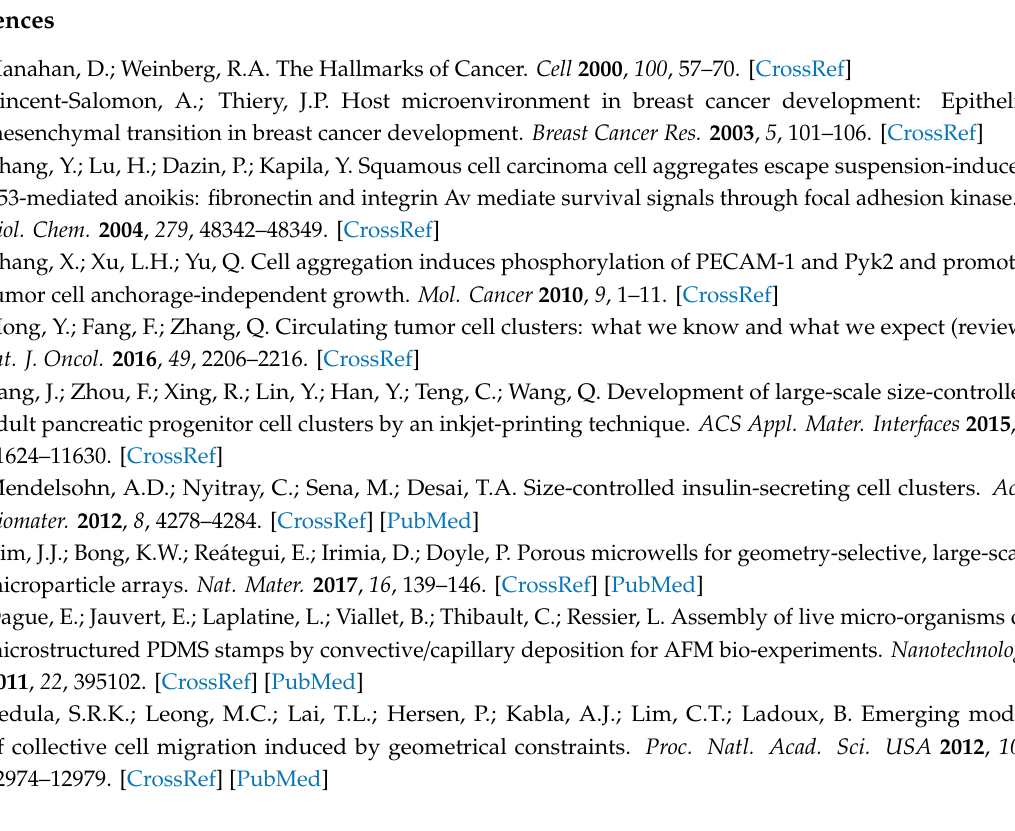
Figure S1: Surface plot (top view) showing the electric field strength in the (a) absence and (b) presence of pillars (filled white circles) in a plane 9.0 µ m above the BPE array under a potential bias leading to a spatially averaged electric field of 4546 V / m. Line plot taken along the midline of the third row of BPEs in the (c) absence and (d) presence of pillars. Figure S2: The data of Figure 2 (main text) plotted with error bars that indicate the standard deviation in the number of cells captured. Plot of the average number of cells captured at each BPE length at ∆ U = 20, 23, and 26 V / min. Data obtained at t = 5 min after initiation of driving tot pp (70 kHz). Flow rate, 200 nL voltage. Figure S3: The data of Figure 4 (main text) plotted with error bars that indicate the standard deviation in the number of cells captured. Plot of the average number of cells captured at each BPE length at ∆ U tot = 26 V pp (70 kHz). Flow rate, 200 nL / min. Data obtained at t = 1 and 5 min after initiation of driving voltage. Figure S4: The data of Figure 5 (main text) plotted with error bars that indicate the standard deviation in the number of cells captured. Plot of the average number of cells captured at each BPE length at ∆ U tot = 50, 60, 70 V pp (70 kHz). Flow rate, 500 nL / min. Data obtained at 5 min after initiation of driving voltage. Table S1: Table of p -values comparing cell cluster sizes at pairs of electrodes lengths as listed at the top of each column. Generated using a one-tailed t-test assuming unequal variances. Movie S1: Video microscopy showing cells held by DEP at the BPE array. The cells are subsequently carried away by fluid flow after the applied voltage is